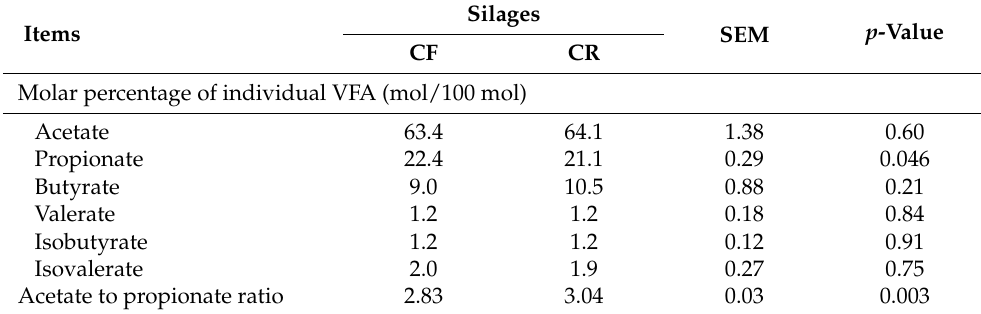
Table 4. Cont. Items